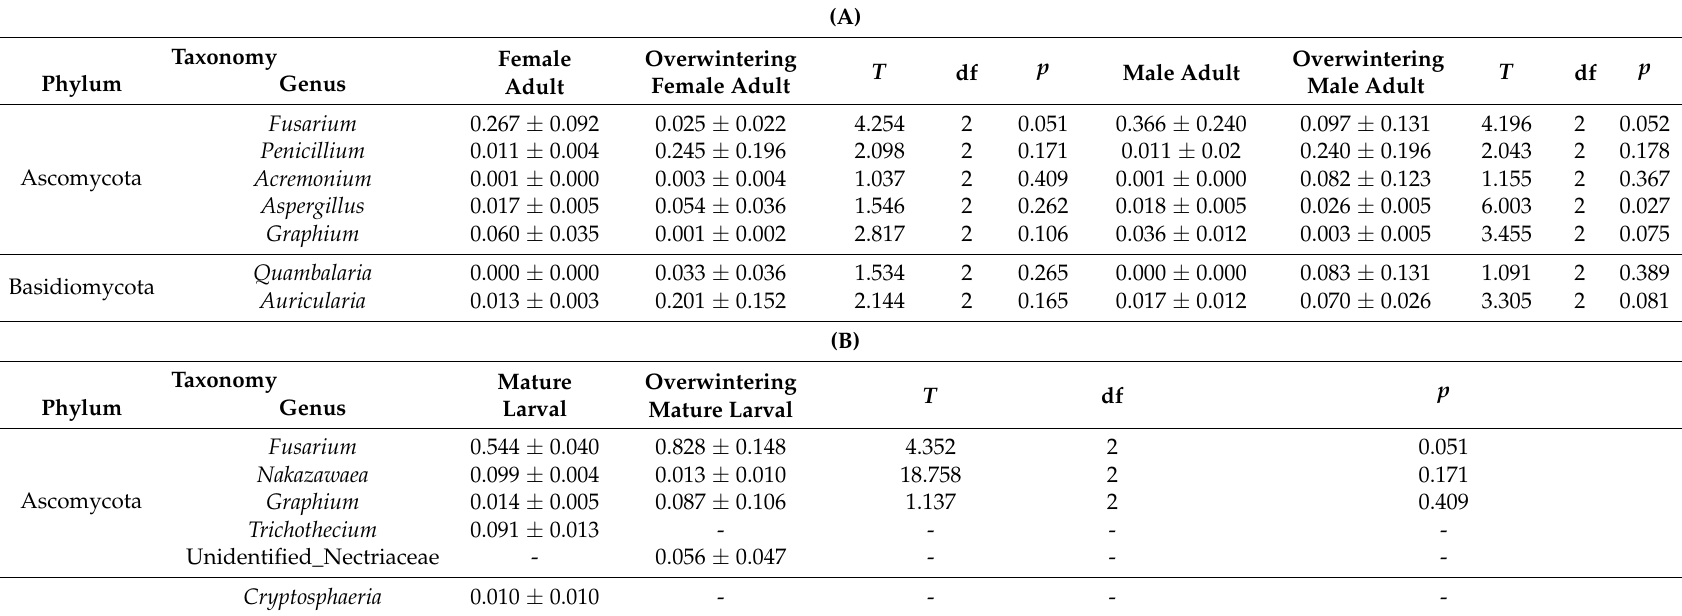
Table A3. The relative abundance of the different fungal taxa in different generation of T. klimeschi at the genus